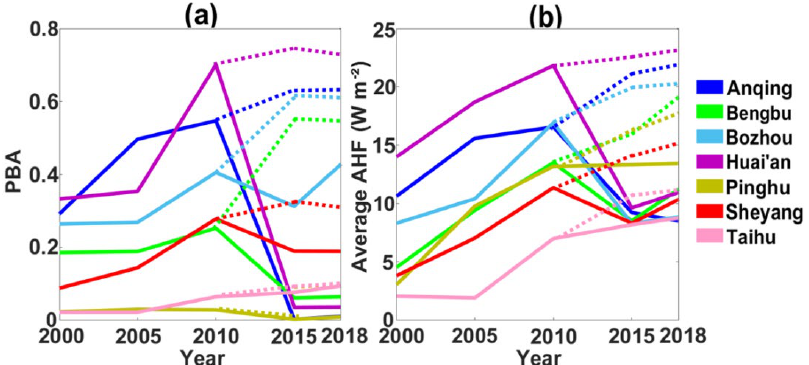
Figure 9. Linear graph of the changes in ( a ) the PBA and ( b ) the average AHF in the 5 km radius buffer zone around the old and new stations. The solid (dotted) line after 2010 represents the surrounding environment of the new (old) station after relocation.